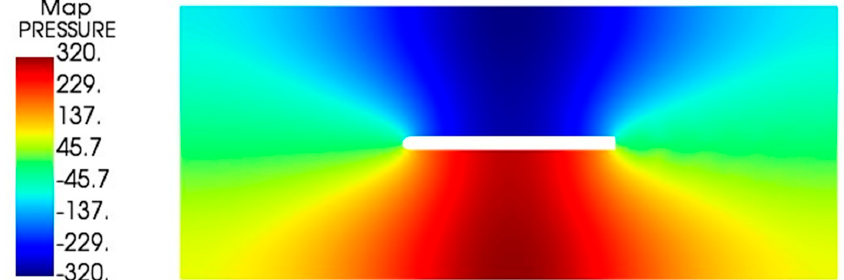
Figure 16. The sound pressure distribution of the acoustic resonance frequency at 511 Hz in present result.